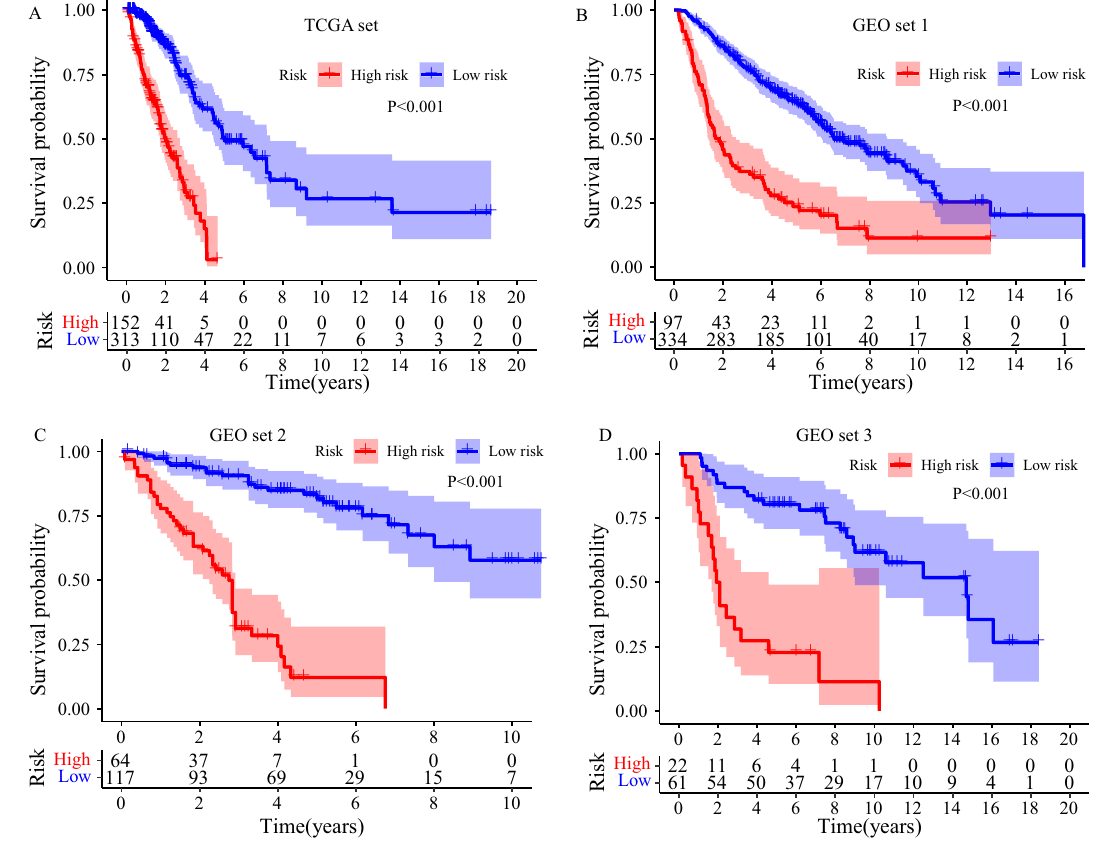
Figure 3. Survival difference between high- and low-risk group ( A ) in the TCGA set, ( B ) in the GEO set 1. ( C ) in the GEO set 2. ( D ) in the GEO set